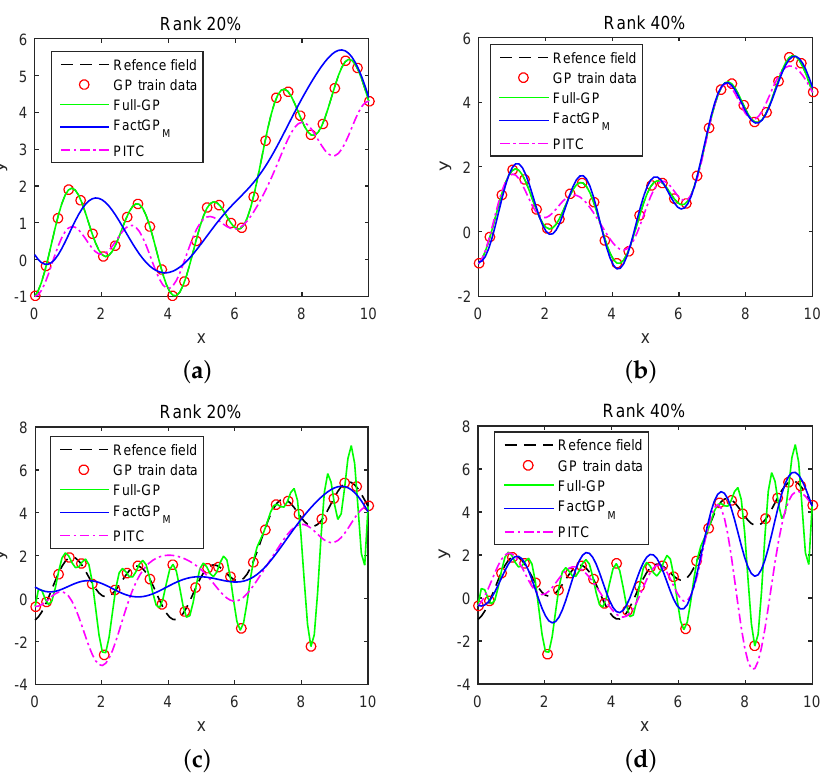
Figure 3. Simulation results on a synthetic example with and without outliers. FactGP M and PITC use kernel matrices whose ranks are either 20% or 40% of the size of the original kernel matrix: ( a ) No outliers with 20% low-rank; ( b ) no outliers with 40% low-rank; ( c ) 20% outliers with 20% low-rank; and ( c ) 20% outliers with 40% low-rank.